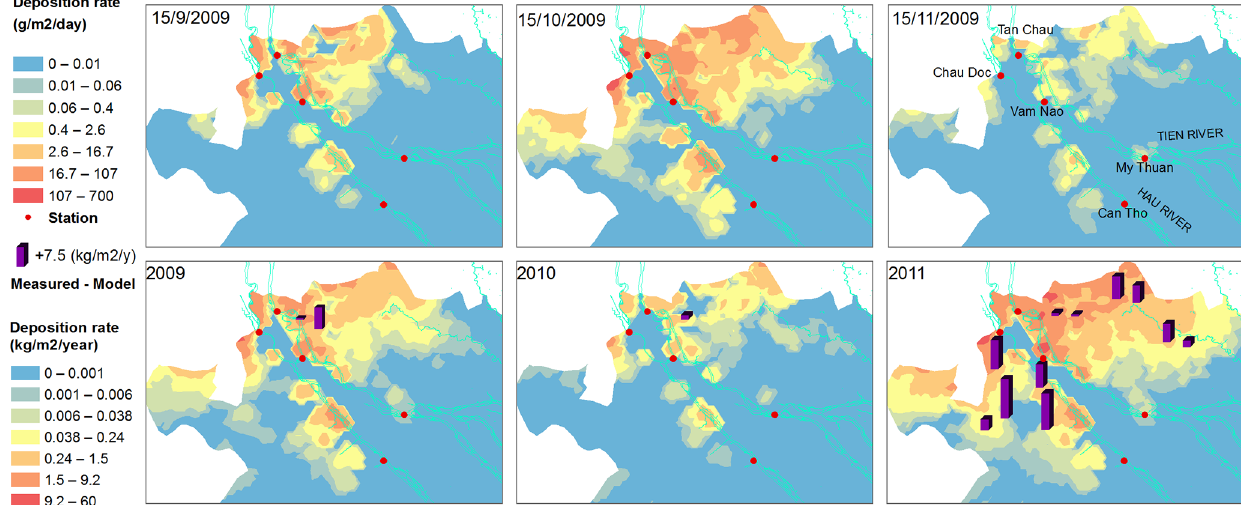
Figure 11. Map of sedimentation in the VMD floodplains. Top panels: sediment deposition rate (gm − 2 day − 1 ) during the period of com- partment opening (left panel), during flood peak discharge (center panel) and during the period of compartment closing (right panel) in the normal flood of 2009. Bottom panels: cumulative sediment deposition (kgm − 2 yr − 1 ) in 2009, 2010 and 2011. The bars indicate the differences between measured and simulated cumulative sediment